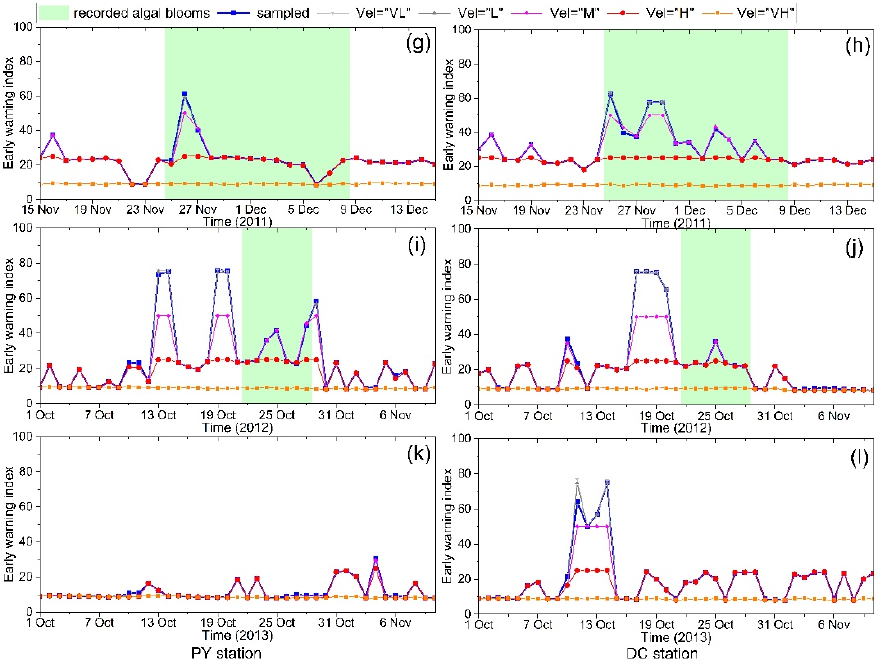
Figure 8. Sensitivity of the warning index to various levels of ∆ DO ( a – f ) and velocity ( g – l ) at the PY station (left panel) and the DC station (right panel). Recorded bloom periods are shaded in green. The warning index, based on original sampled data, is shown in blue.